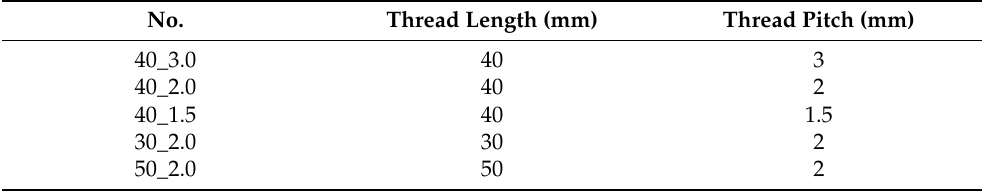
Figure 1. Test specimens (units: mm); ( a ) threaded specimen; ( b ) threadless specimen (source elaborated by authors). Table 1. Threaded specimens for modal tests (source elaborated by